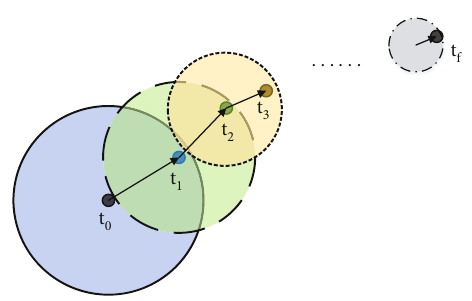
Figure 6: Diagram of the Spacecraft Using PSO Algorithm to Search the